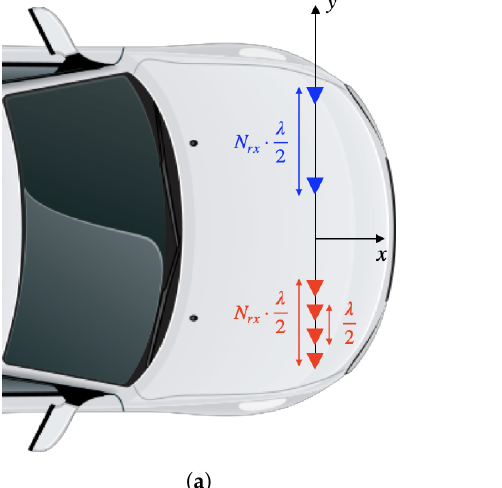
Figure 1. ( a ): Real array configuration for an 8-channel automotive radar made up by two transmitting antennas (in blue) and four receiving antennas (in red) in forward-looking configuration. ( b ): Virtual array for an 8-channel automotive radar spaced by λ /4 in forward-looking